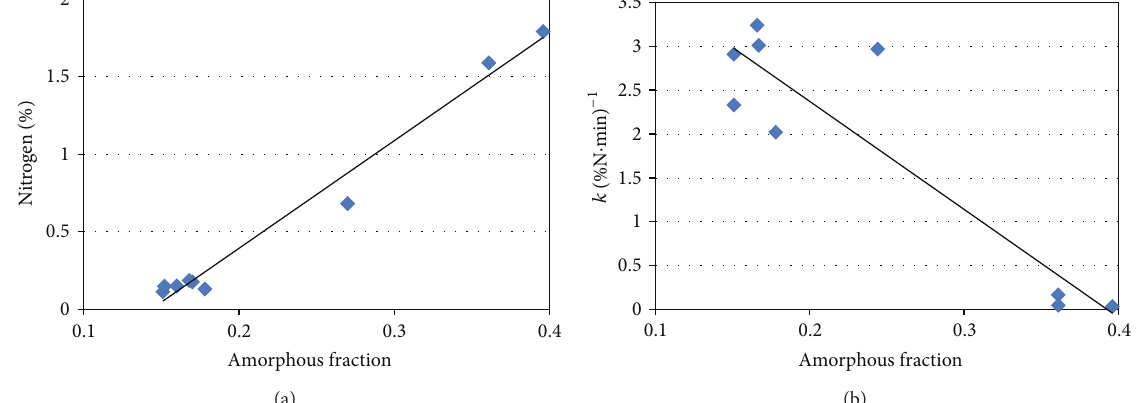
Figure 4: Percentage of nitrogen in cellulose after cationization following alkalization with aqueous solutions of (a) NaOH 10%, (b) NaOH 20%, and (c) NaOH 30%.